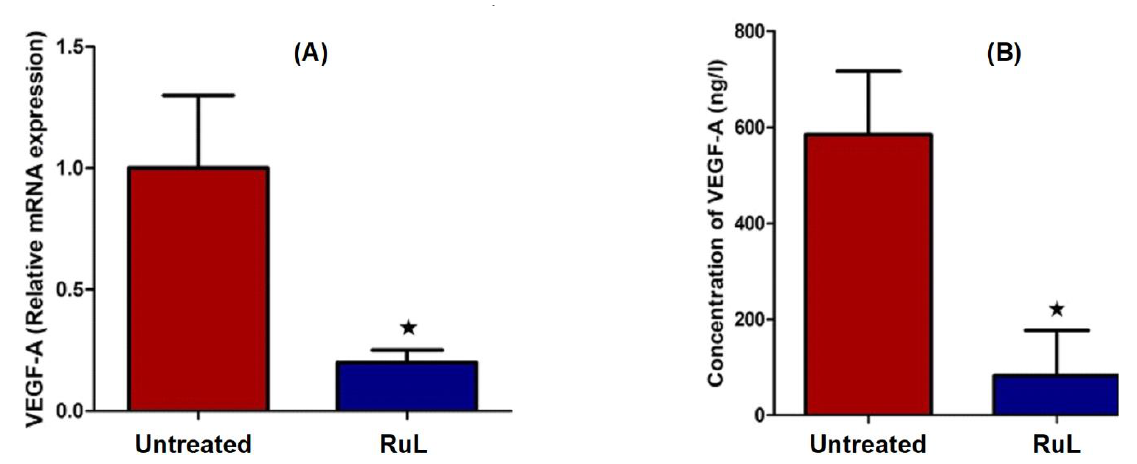
Figure 8. Effect of RuL treatment on VEGF in HepG2 cells: ( A ) RT-PCR gene expression; ( B ) protein level. Results are expressed as mean ± SD of two independent experiments performed in triplicate. Statistical differences were analyzed with a t -test. * Significant at p < 0.05.